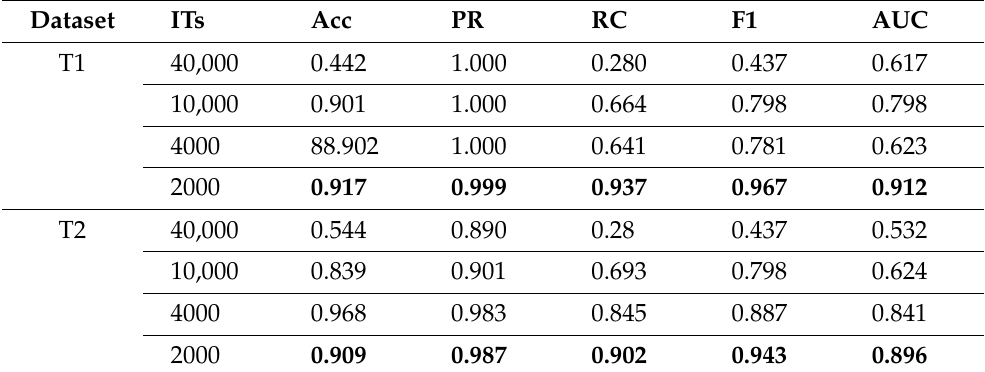
Table 3. The results of the 2D custom model after trained on normal and synthetic data then tested with ‘Testdata1’ (noted as T1) and ‘Testdata2’ (noted as T2)’, the bold scores indicate the highest mean scores obtained in test phase. Note: Number of training instances